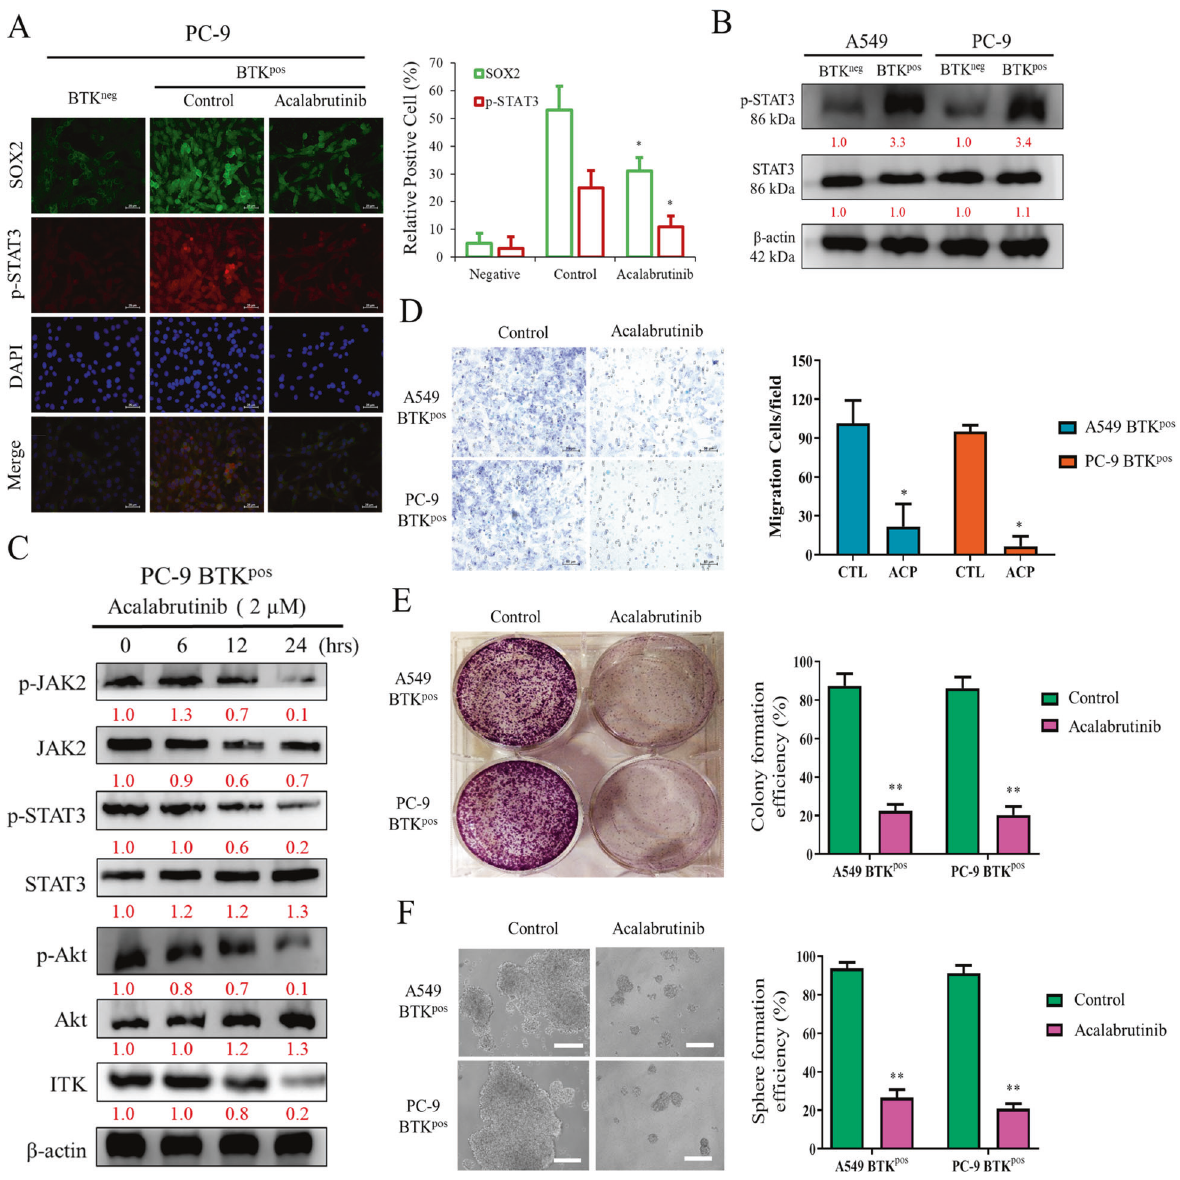
Fig. 3 BTK regulates invasive phenotypes via the JAK2/STAT3 pathway in NSCLC cells. A Immuno fl uorescence study showed the level of SOX-2 and p-STAT3 were parallel in PC-9 cells with different status of BTK. Scale bar 50 μ m. B p-STAT3 expression was upregulated in BTK pos cells derived from both A549 and PC-9 cells. C Expression of p-STAT3, p-JAK2, p-Akt, and ITK in BTK pos PC-9 cells were suppressed by Acalabrutinib in a time-dependent manner. Effect of Acalabrutinib on D cell migration (scale bar 20 μ m), E colony formation, and F sphere formation (scale bar 50 μ m) in BTK pos A549 and PC-9 cells are present. CTL control. * p < 0.05, ** p <